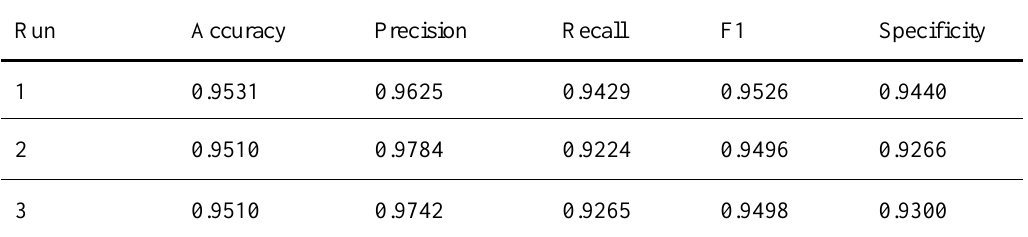
Table 2. Performance metrics for MCCV (five